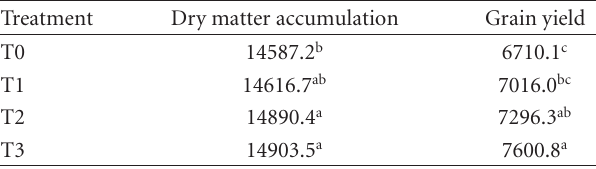
Table 4: E ff ect of irrigation during the winter wheat growing season on the dry matter accumulation at maturity and grain yield of sum- mer maize (kg · hm − 2 ).